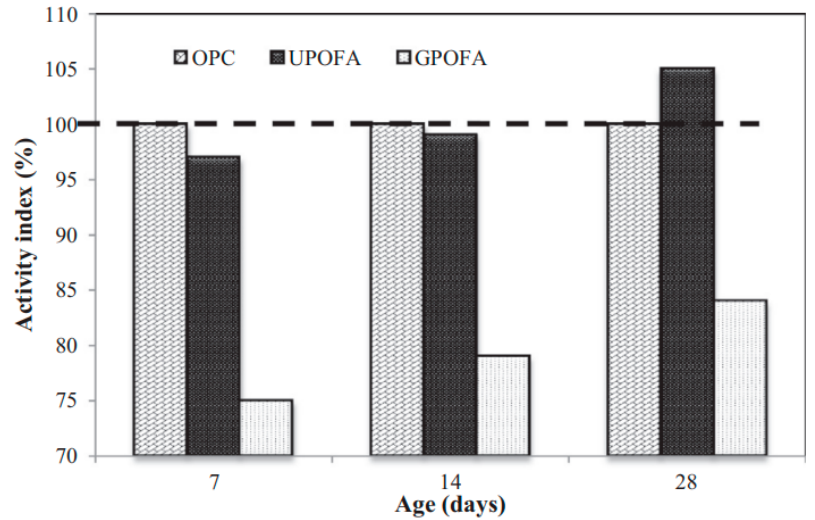
Figure 13. SAI of POFA mortar at different curing period [136]. Reprinted with permission from Elsevier [136].